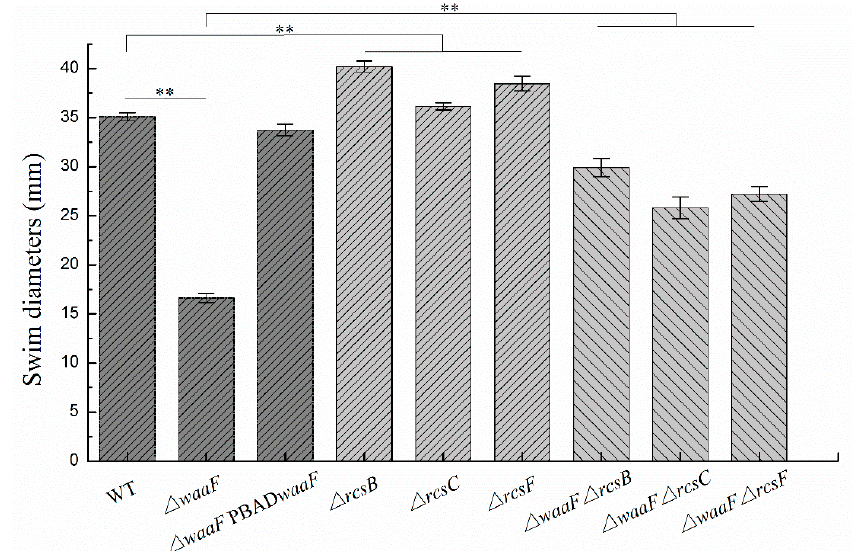
Figure 4. Changes in swim motility of wild-type and mutant strains of Y. enterocolitica . Y. enterocolitica was grown in LBNS semisolid plates supplemented with 0.6 g/L L-arabinose at 26 °C. Swim diameters were measured after 48 h of incubation. Data are average values and standard deviations of triplicate experiments. The statistical comparison shows that there is a significant difference between WT (wild-type) and Δ waaF ; there is a significant difference between WT and Δ rcsF / Δ rcsC / Δ rcsB single mutant; there is a significant difference between Δ waaF and Δ waaF - Δ rcsF / Δ waaF - Δ rcsC / Δ waaF - Δ rcsB double mutant. An asterisk indicates a significant difference with ** p < 0.01.